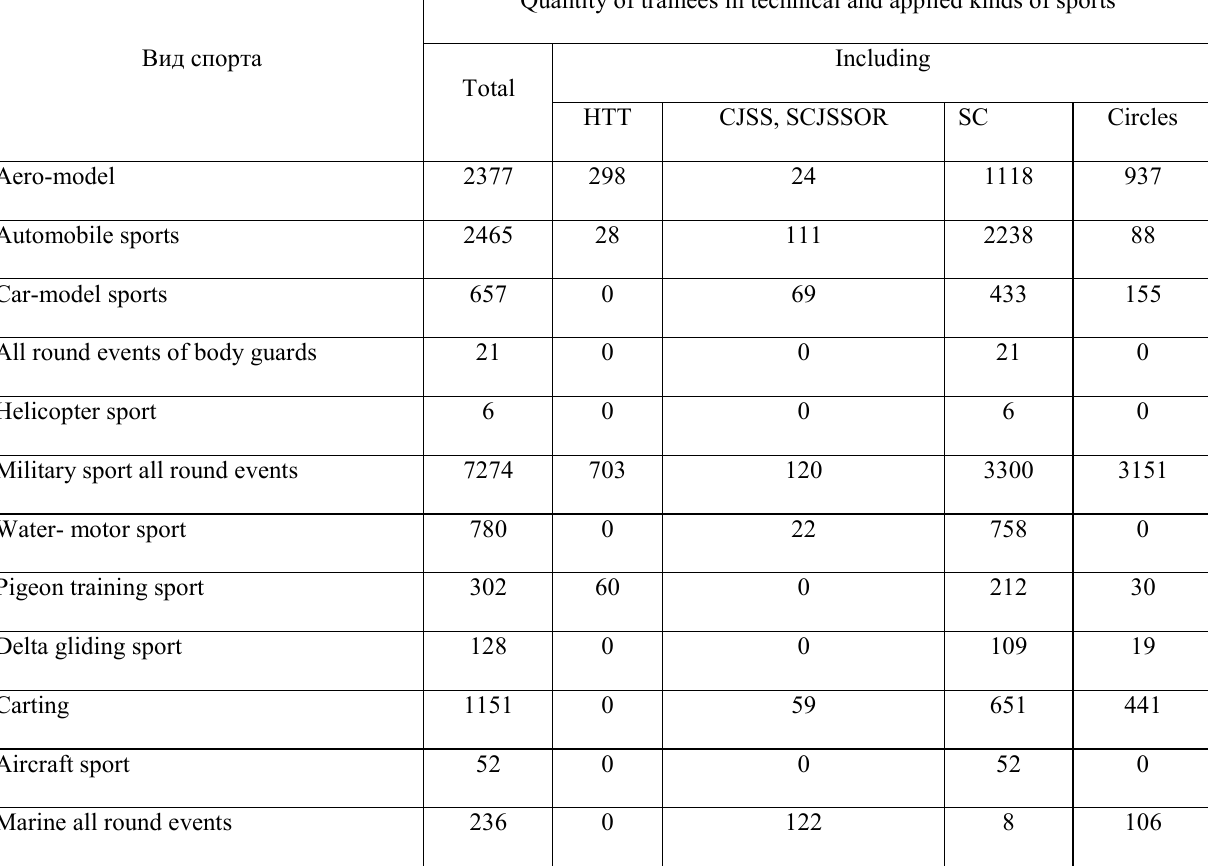
Development of technical and applied kinds of sports in physical culture organizations of Ukraine in 2013 Quantity of trainees in technical and applied kinds of Вид спорта